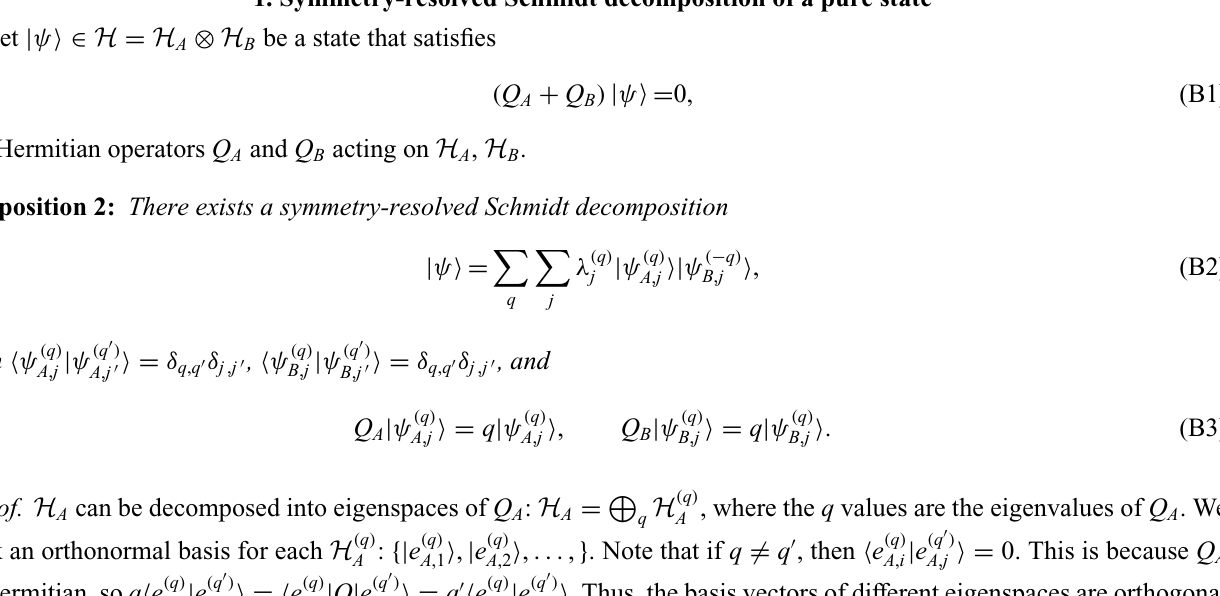
FIG. 4. Entanglement detection. We consider a reduced density matrix ρ AB defined on the subsystem A = [1, 2] and B = [3, 4] for the 10-ion experiment of Ref. [7]. In (a), we plot as detection on the vertical axis, the condition given in Proposition 1, ( S ( 2 ) (ρ AB ) − R ( 2 ) (ρ AB )) and, similarly, in (b) we use the optimal condition in Eq. (7) of Ref. [65] ( E π the partitions A and B for various times t during the quench dynamics when we observe values greater than 0. The points show experimental results with the error bars calculated using jackknife resampling. The solid lines correspond to numerical simulations of the unitary dynamics, including